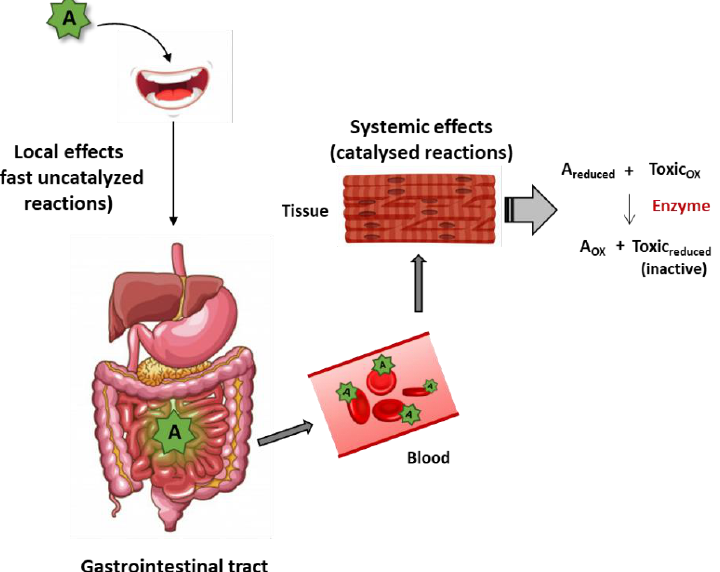
Figure 1. Scheme of direct antioxidant mechanisms including local e ff ects by fast uncatalyzed reactions and systemic e ff ects due to catalyzed reactions. A—antioxidant, A ox —oxidized antioxidant, A reduced —reduced antioxidant, Toxic ox —oxidized toxic, Toxic reduced —reduced toxic (non-toxic in reduced